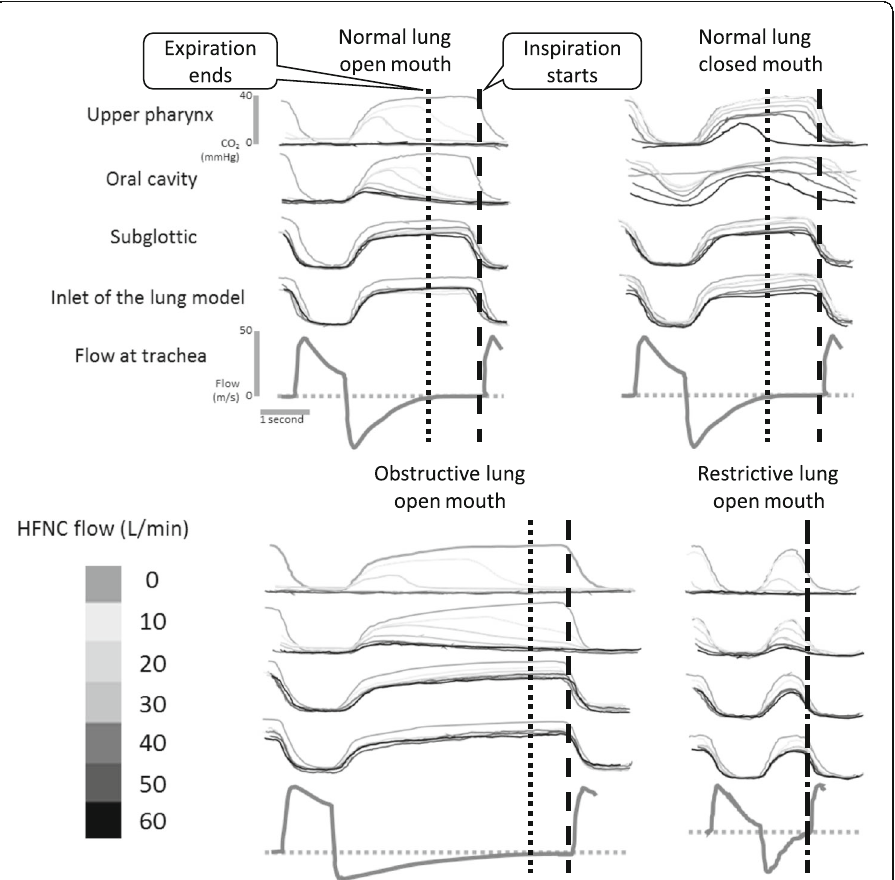
Fig. 3 Capnograms and airway flows recorded. Capnograms were recorded with an HFNC flow of 10 – 60 L/ min in each lung model. Airway flows were recorded without HFNC by the flow sensor in the lung model. There were no differences between the capnograms recorded at the subglottic and the inlet sites of the lung model, indicating the flow generated by HFNC does not reach further than the subglottic area. In open-mouth models, an HFNC flow of 10 – 20 L/min washed out the CO 2 of the upper pharynx and the oral cavity. The closed-mouth model needed more HFNC flow to wash out the CO 2 of the upper pharynx and the oral